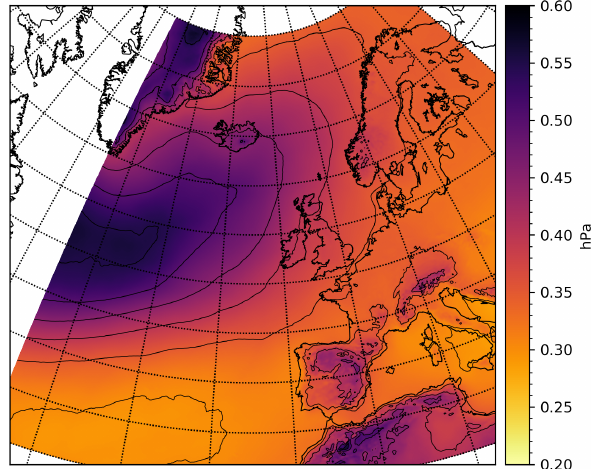
Figure 6. ECMWF-IFS absolute hourly pressure change for the first 18h ( + 0h through + 18h) forecast – averaged over all 4384 (four daily) forecasts during 2016–2018. The spatial average over the neatl area (Fig. 5) is 0.42hPa.